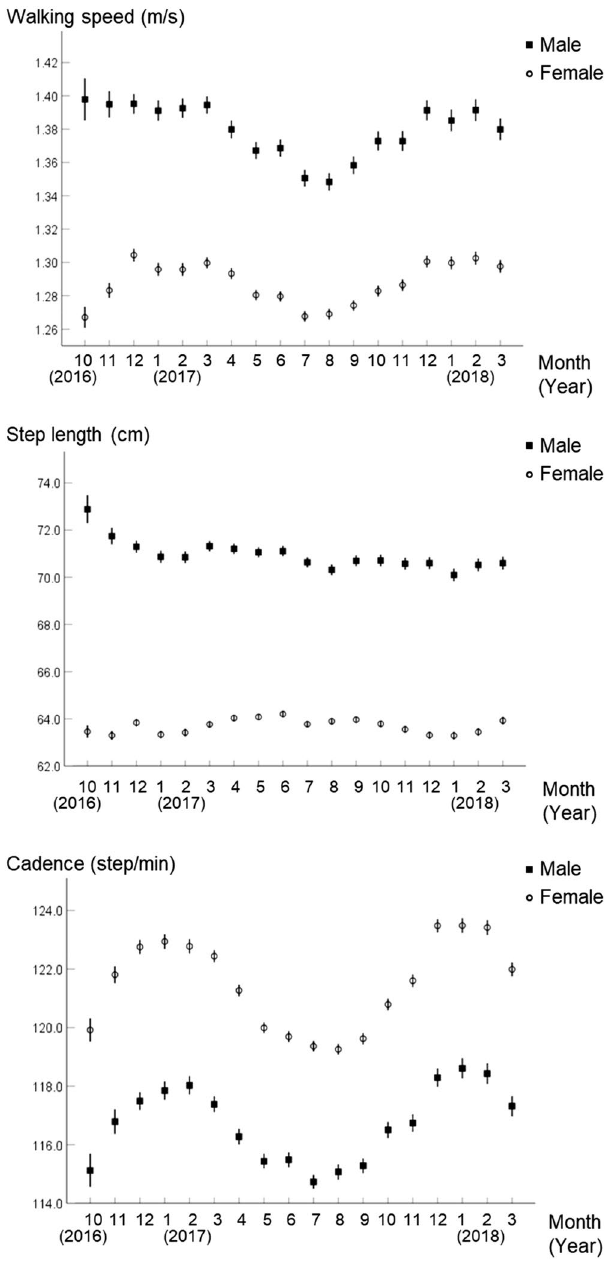
Figure 1. Seasonal changes in walking speed, step length, and cadence (error bar: 95% confidence interval, N =